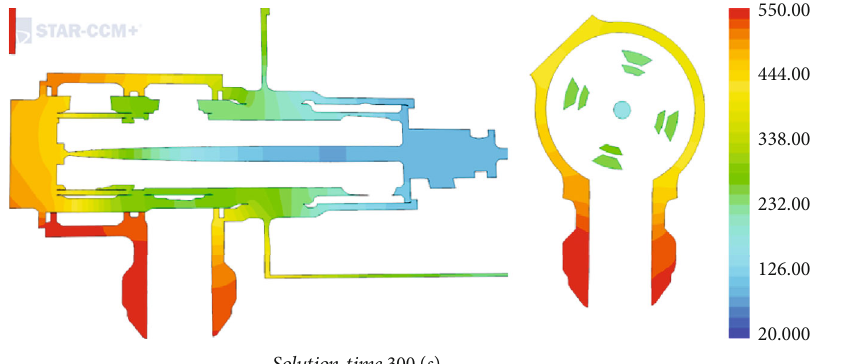
Figure 9: Temperature of the oil return pipe fi re zone at t = 5 minutes.